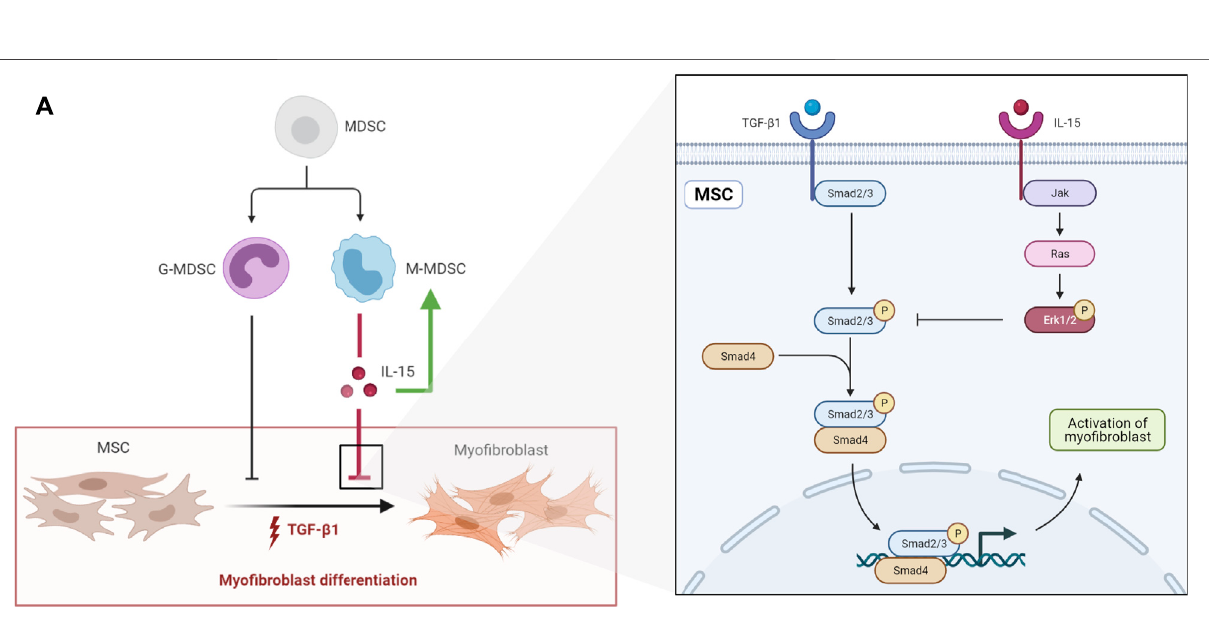
FIGURE 8 | (A) schematic diagram depicting the effects of MDSCs on the myo fi broblastic differentiation of MSCs. G-MDSCs and M-MDSCs both have inhibitory effects on the myo fi broblastic differentiation of MSCs. M-MDSCs exert inhibitory effects through IL-15/Ras/Erk/Smad signaling. Additionally, M-MDSC supernatant promoted the proliferation of M-MDSCs sup via